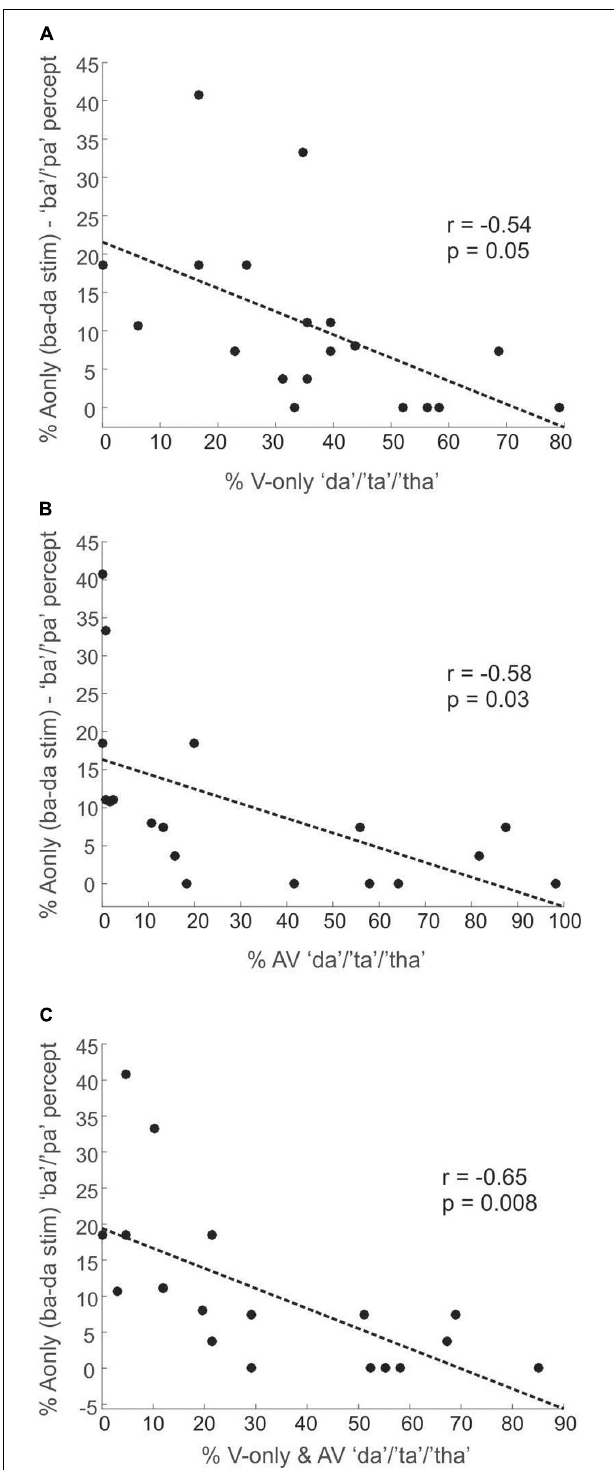
FIGURE 3 | Plots depicting Experiment1 correlations between percentages of the “ba”/“pa” percept of the A-only /ba–da/ stimuli (superimposed /ba/ and /da/ CVs) and the overall response percentages of the “da”/“ta”/“tha” percept (across all stimuli except /ba/) for the V-only condition (A) , the AV condition (B) , and the mean of the V-only and AV conditions (C) .